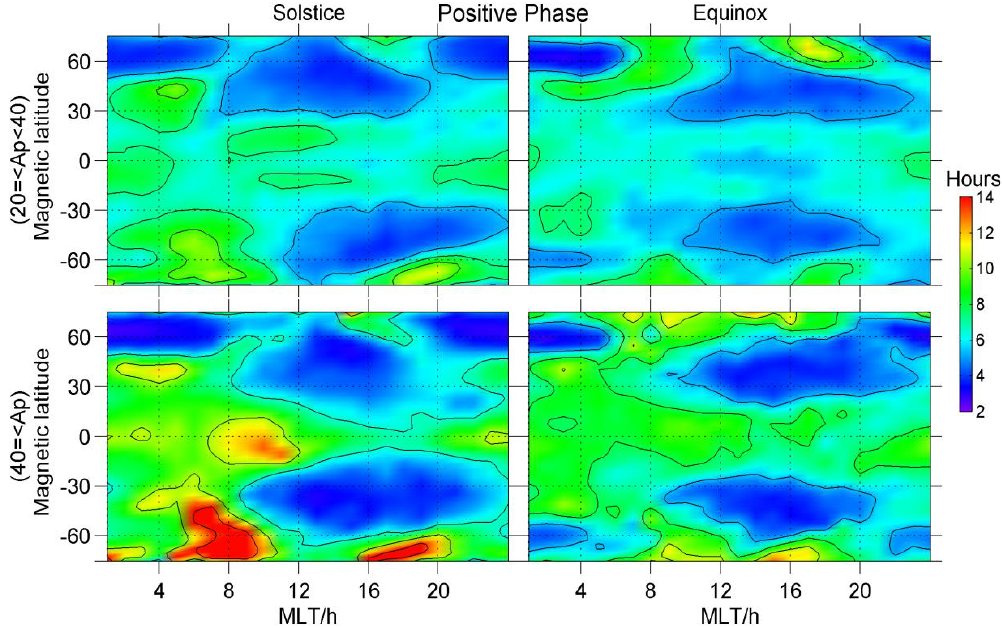
Fig. 4. Global distribution of the mean time delay related to positive ionospheric storms in the MLAT vs. MLT frame for solsticial months (left panels) and equinoctial months (right panels). The Northern Hemisphere of left panels locates in winter and the Southern Hemisphere corresponds to the summer months.